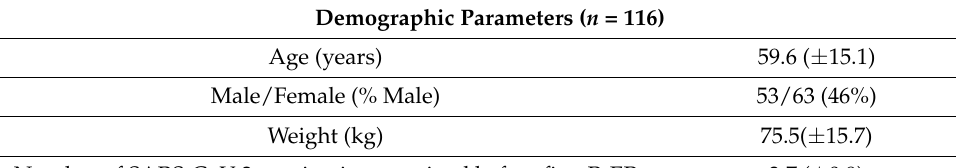
Table 1. Patient